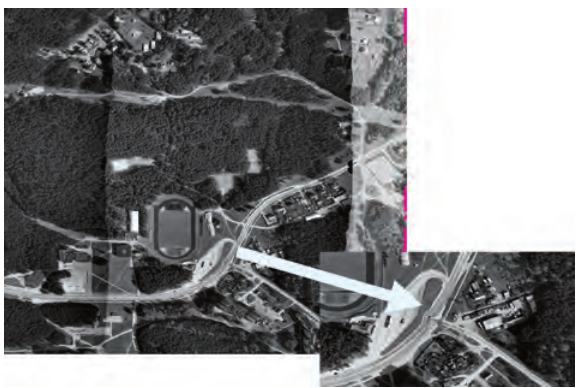
Fig. 3. Orthophoto with visible radiometric and objects position deformations